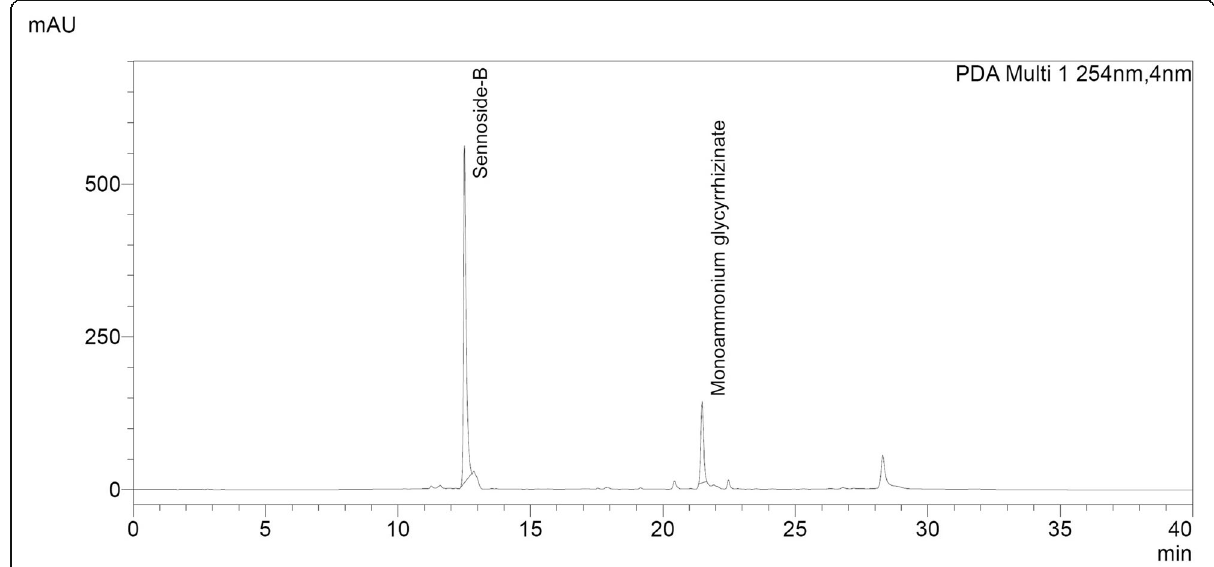
Fig. 1 HPLC chromatogram of mixture of monoammonium glycyrrhizinate and sennoside-B